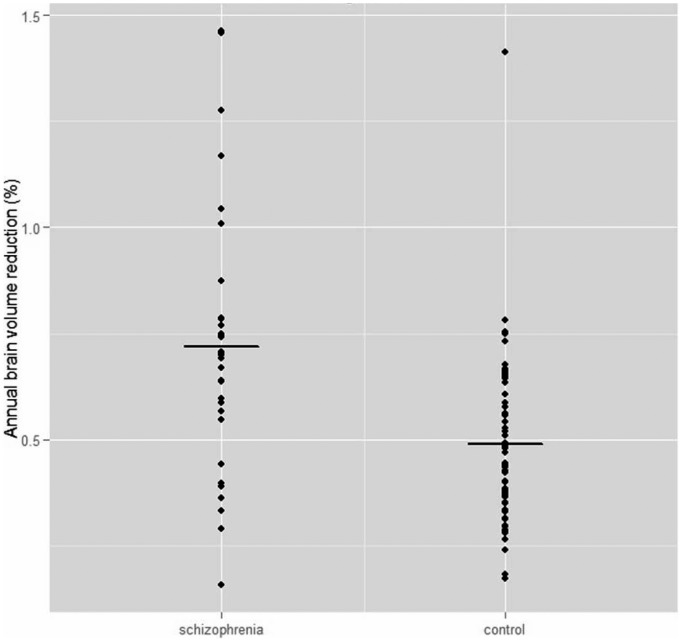
Scatter blot of annual brain volume change in schizophrenia and control groups.